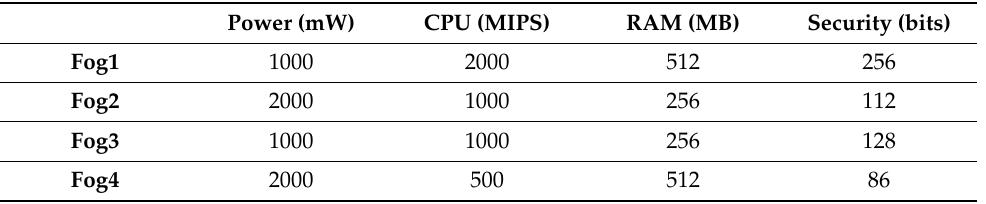
Table 2. Resources available in the fog